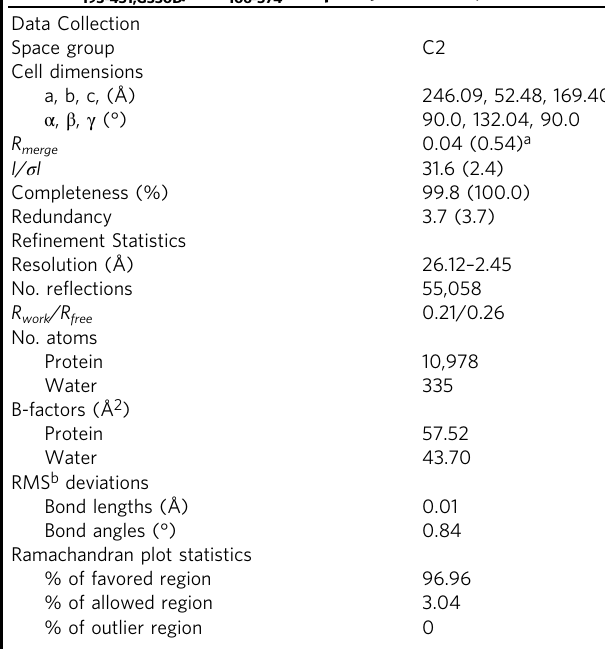
a Values in parentheses refer to highest-resolution shell. b RMS root mean